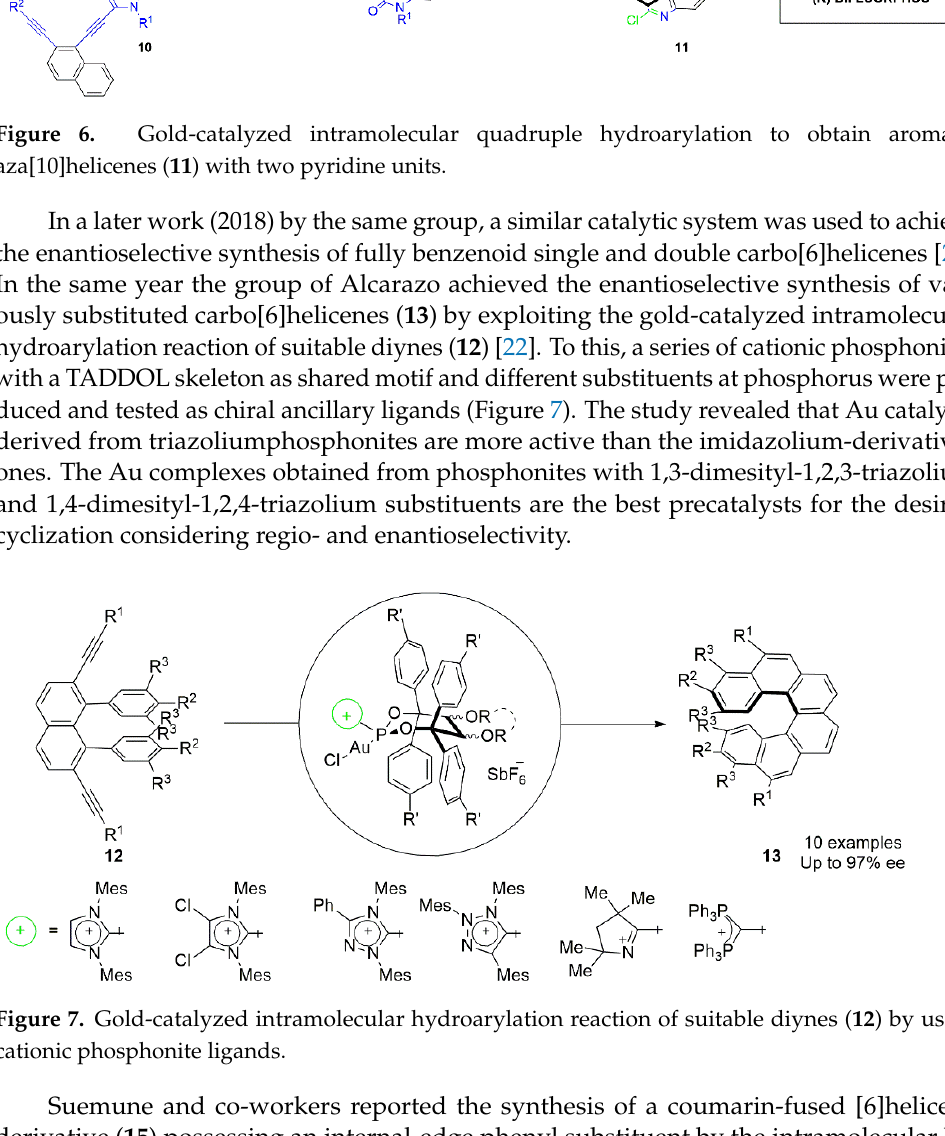
Figure 6 . Gold-catalyzed intramolecular quadruple hydroarylation to obtain aromatic aza[10]heli- Figure 6. Gold-catalyzed intramolecular quadruple hydroarylation to obtain aromatic cenes ( 11 ) with two pyridine units. aza[10]helicenes ( 11 ) with two pyridine units.